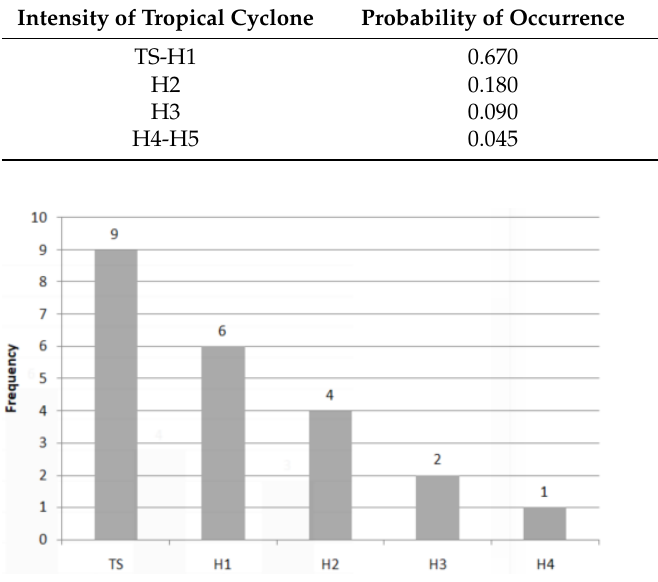
Figure 5. Impact of tropical cyclones in Baja California Sur state for the period 1970–2020. Table 3. Scenarios of storm surge and their relationship with the intensity of tropical cyclones and their probability of occurrence.